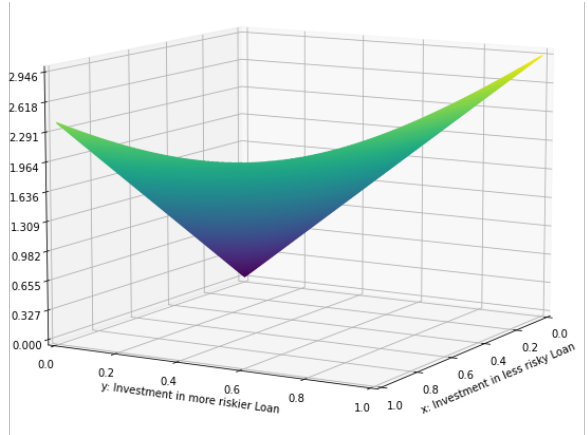
Figure 3. Unexpected Loss against investments in risky